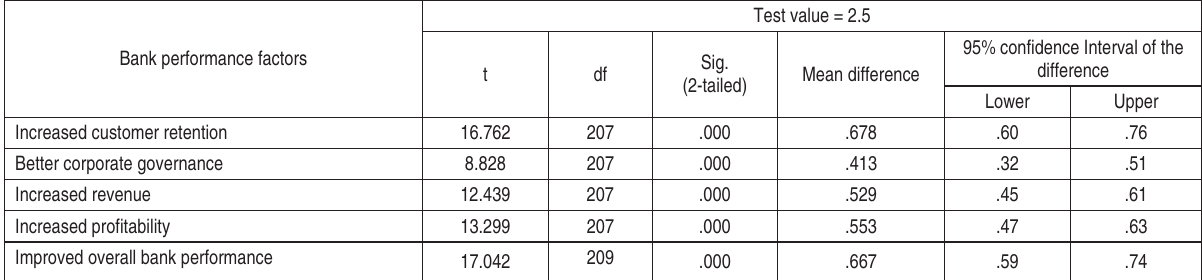
Table 7. One sample t-test – emotional Intelligence on bank performance